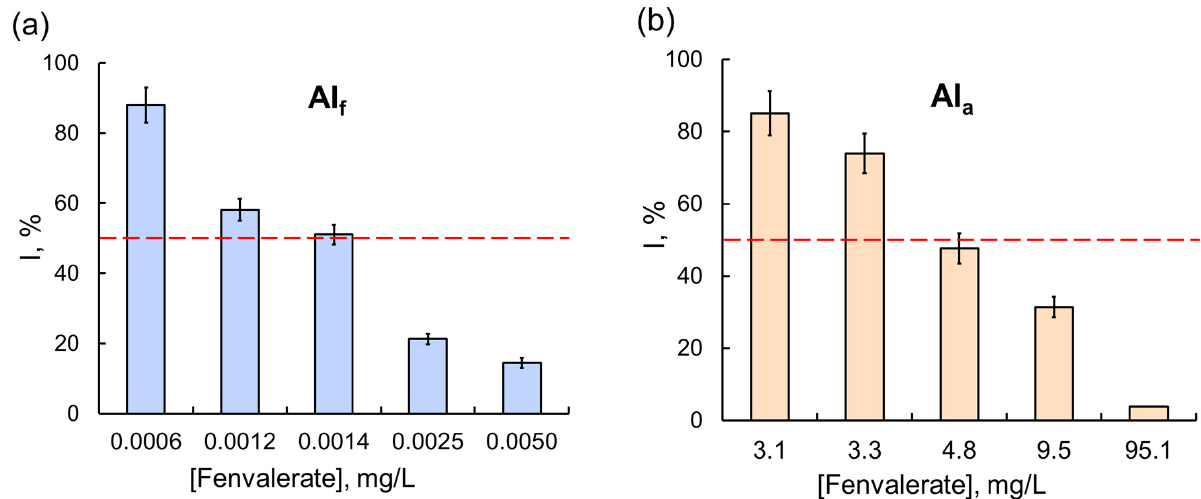
Figure 5. The effects of ( a ) the Sempay commercial pesticide formulation (with fenvalerate as the active ingredient) and ( b ) fenvalerate as AIa on the Red + Luc coupled enzyme system. The same as for glyphosate, the inhibitory effect of fenvalerate as AIf on the Red + Luc system was stronger than the effect of fenvalerate as AIa; the values of IC 50 for fenvalerate as AIf and AIa were 0.0014 and 4.8 mg/L, respectively.